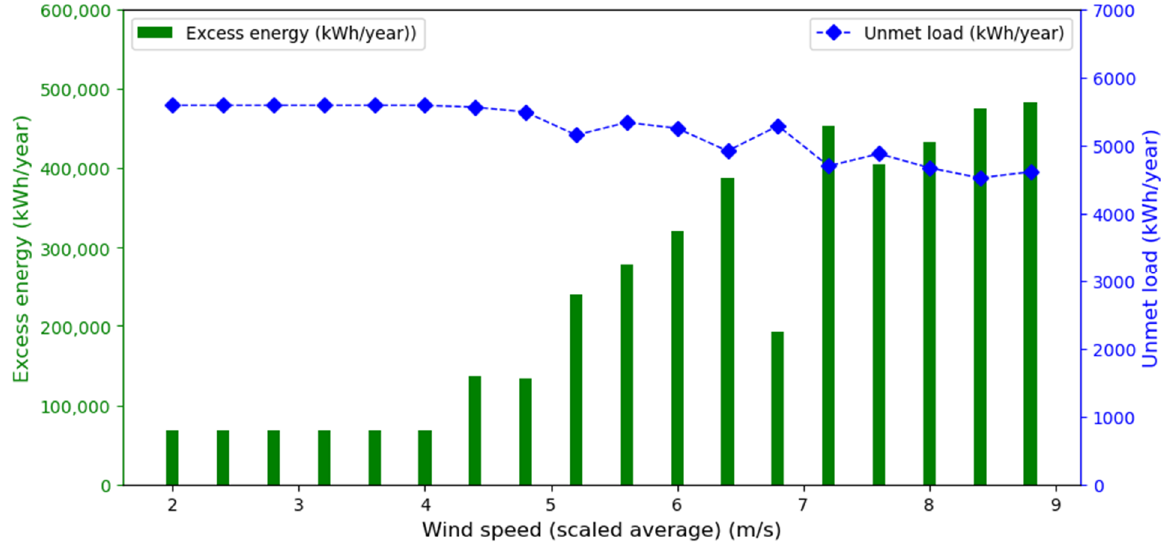
Figure 15. The effect of wind speed variation on the technical performance of the Sokoto PV/WT/battery EV charging model.